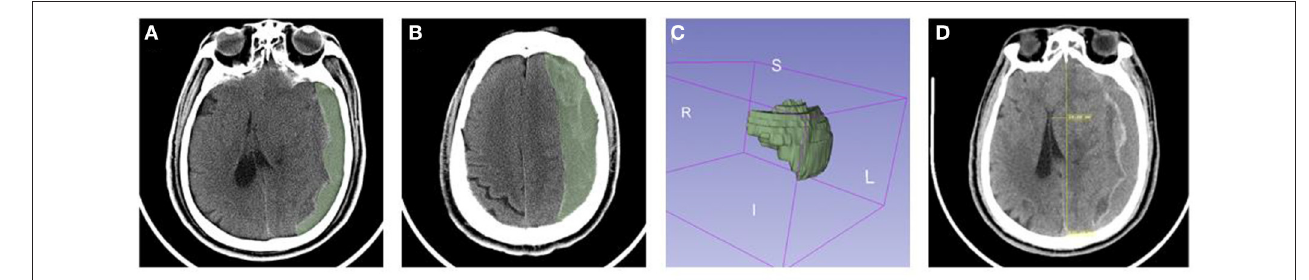
FIGURE 2 | The CT images of CSDH with mixed density were analyzed with 3D slicer. (A–C) Calculation of the volume of hematoma. (D) Measurement of mid line shift.